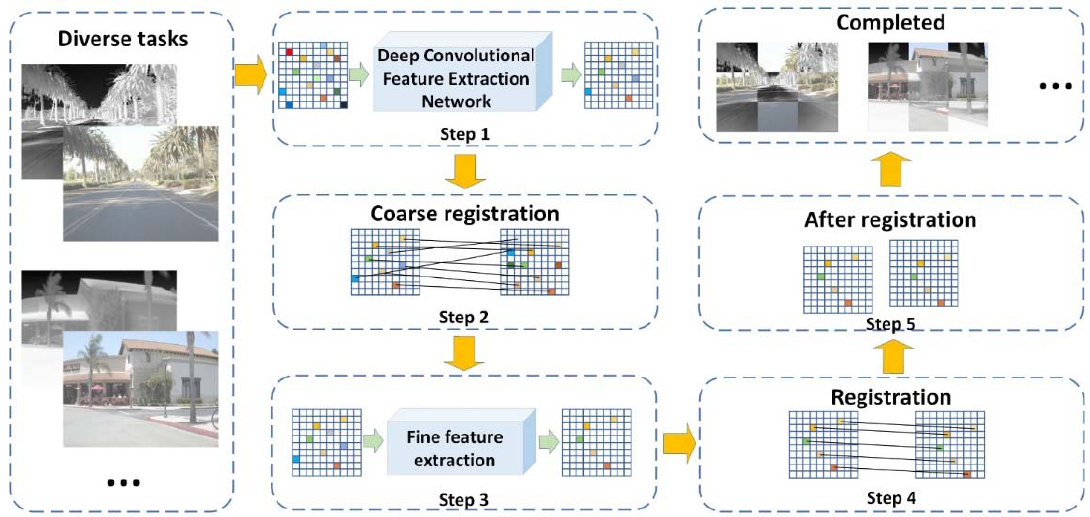
Figure 1. The algorithm framework of the article.